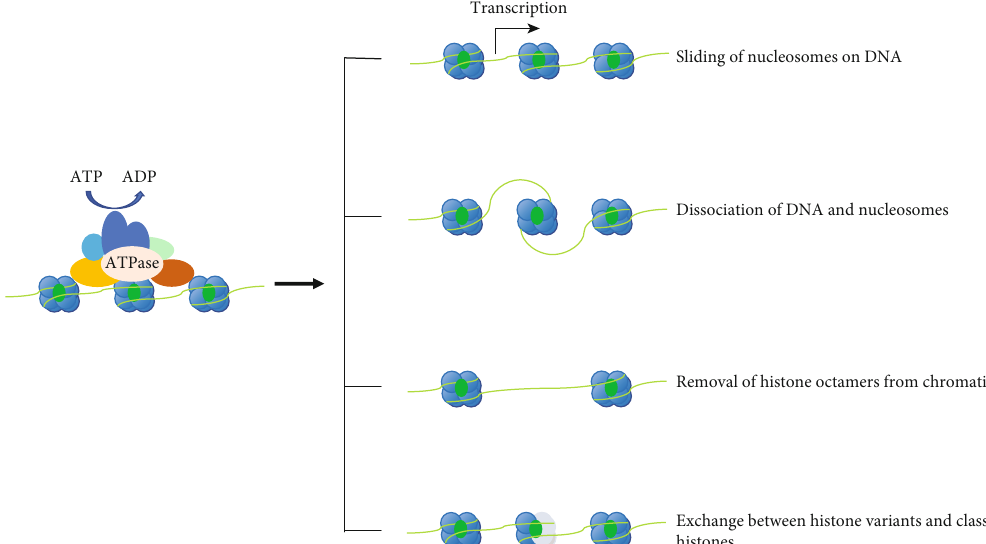
Figure 1: Schematic of the chromatin remodeling complex functional mode. Chromatin remodeling complex, which has ATPase activity, could change the structure of nucleosomes with the energy generated by hydrolyzing ATP, to regulate the accessibility of chromatin and further a ff ect gene